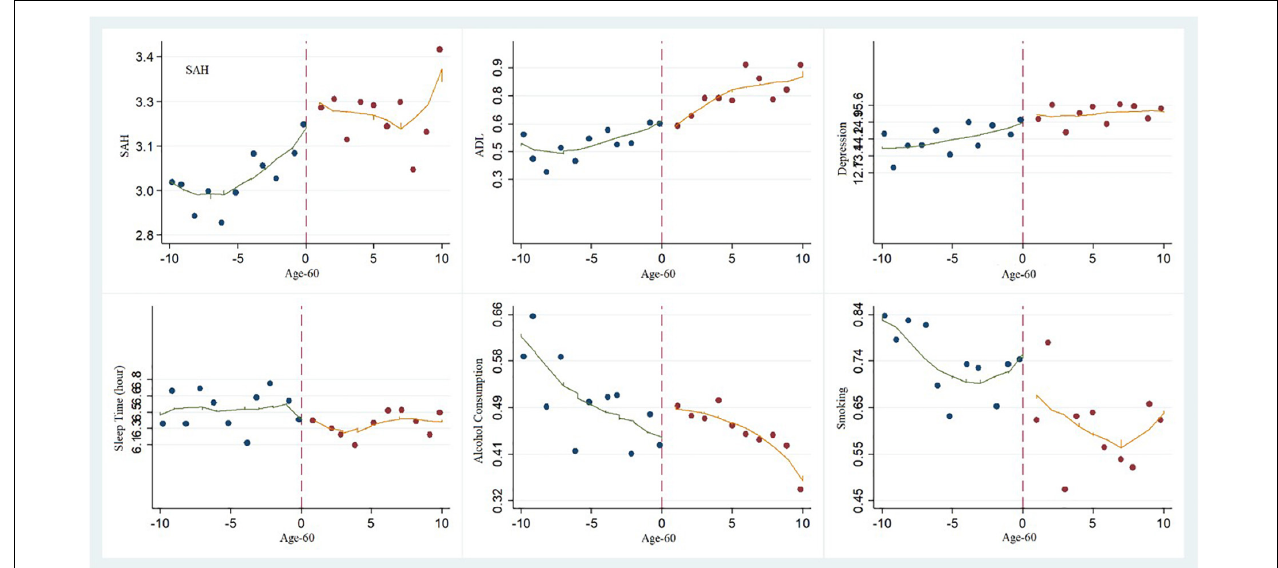
FIGURE 2 | Local polynomial regression diagram: the breakpoint characteristics of health and living habits.